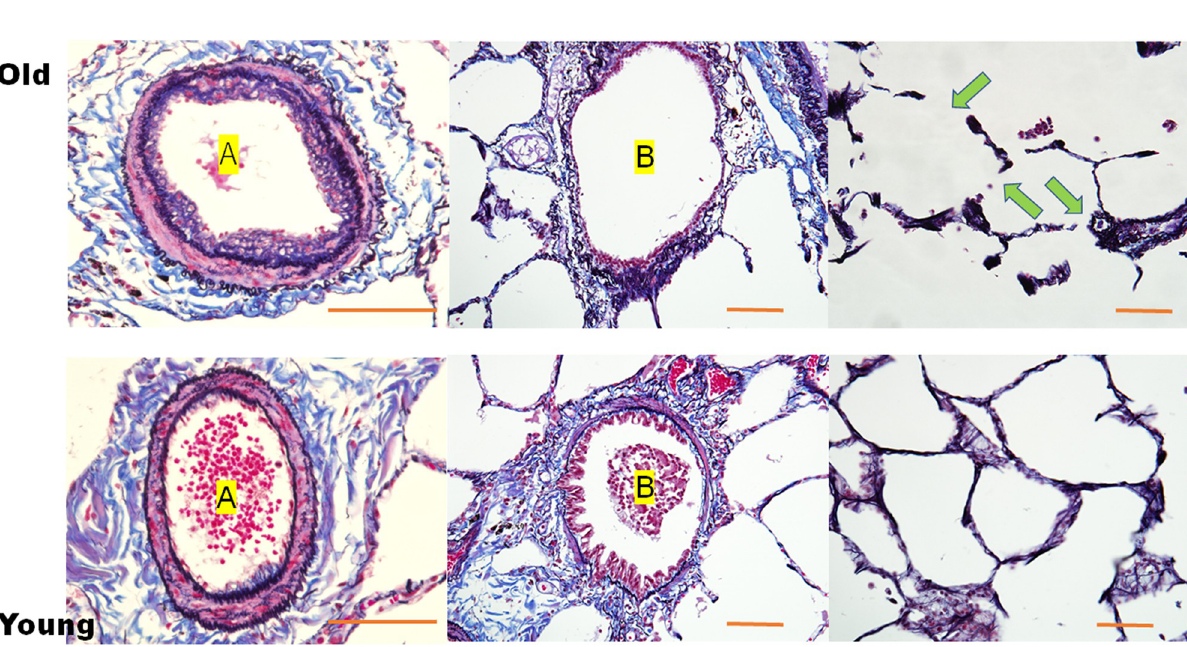
Fig 4. LM images of sections stained with Verhoeff’s elastic and Masson’s trichrome stain. In the old group (upper row), lungs are composed of arterioles (A) with a thin muscle layer and thick atheromatous intima, bronchioles with weak and poor collagen surroundings and sparse epithelial cells, and large alveoli composed of walls of varied thickness or disconnection (arrows). These splits are artifacts introduced during processing because of the lower mechanical resistance of old lung tissue. Conversely, young lungs (lower row) are composed of arterioles (A) with thick, smooth muscle; bronchioles (B) with concrete collagen surroundings and dense epithelial cells; and continuous alveolar walls with a regular size. Scale bar = 100 μ m.